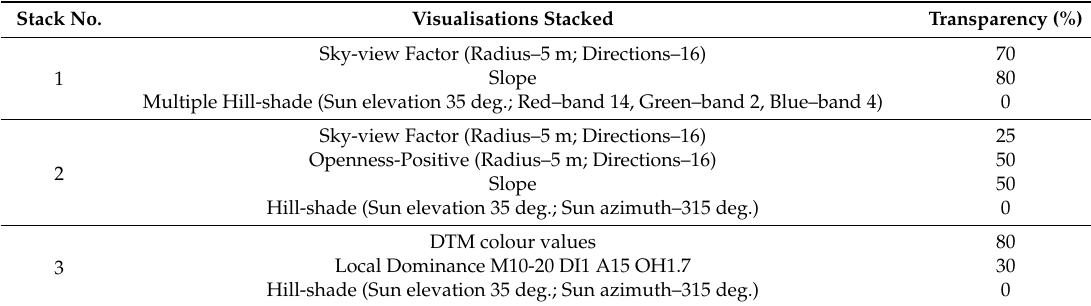
Table 1. Three sets of DTM visualisations, developed by Žiga Kokalj (1, 2) and, Łukasz Banaszek (3), were used as the primary source for the desk-based interpretation. Stack